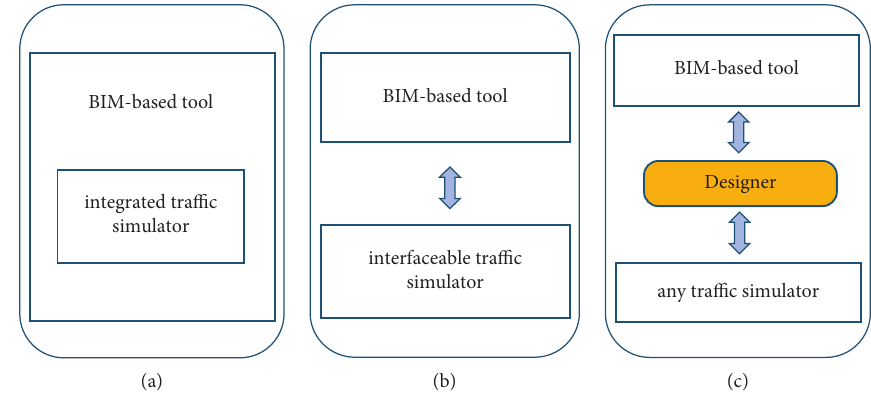
Figure 1: Alternative options for designer engineers: (a) integrated solution; (b) interfaceable solution; and (c) standard solution.